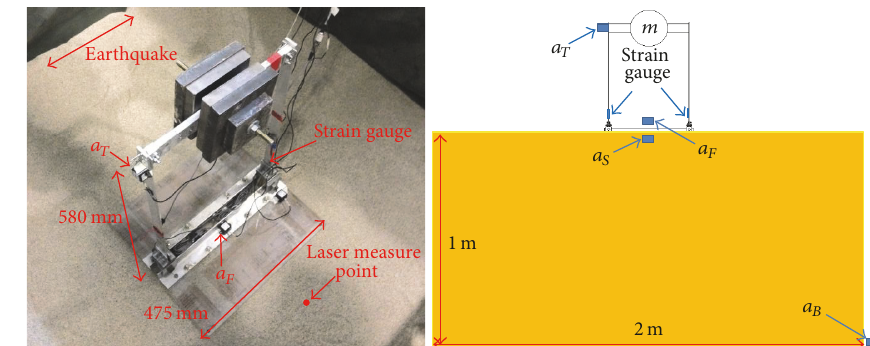
Figure 6: Setup of the model and instrumentation.